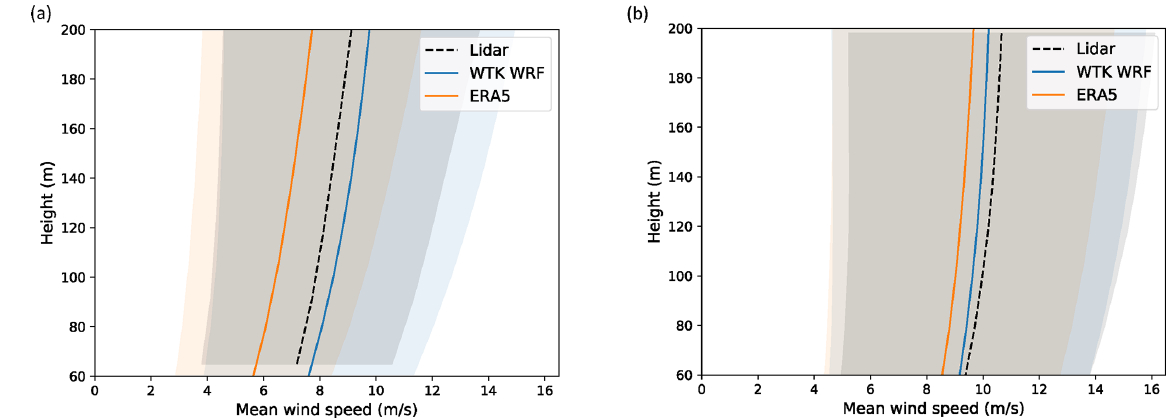
Figure 4. Mean vertical wind speed profiles for all three data sources at (a) the land-based SGP site and (b) the offshore E05 floating lidar. The shaded bands represent ± the standard deviation of the